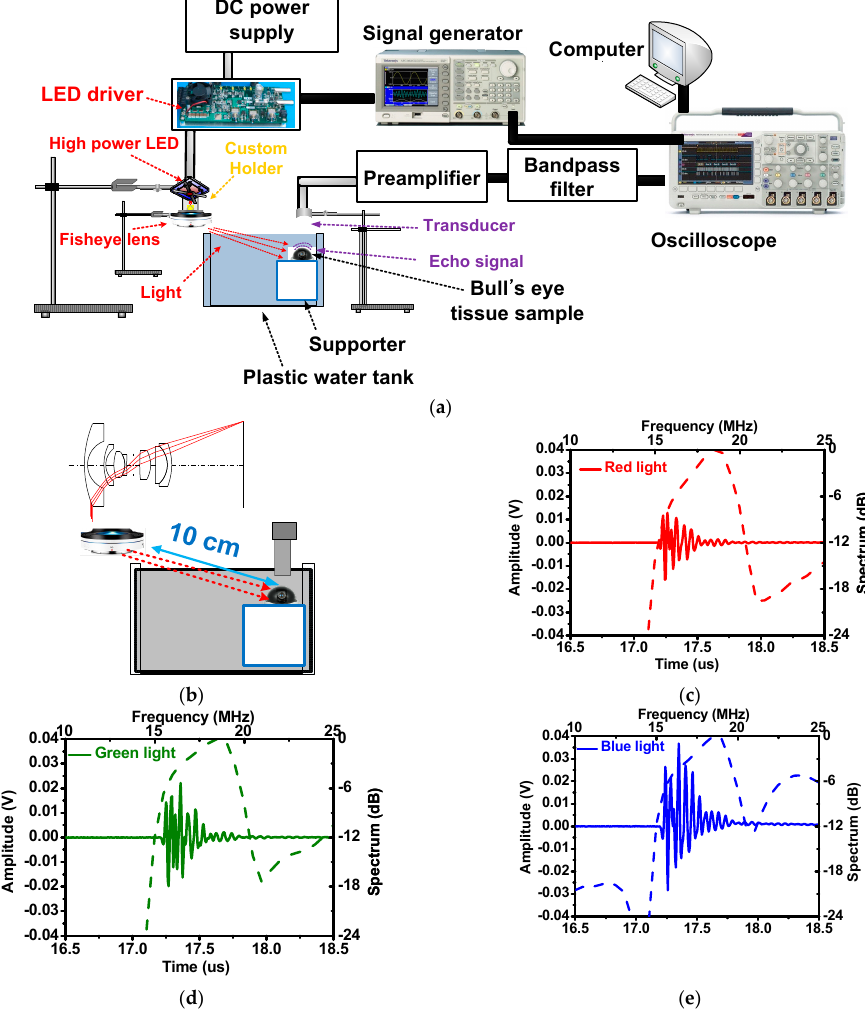
Figure 8. ( a ) Fisheye-lens-based PA system setup, ( b ) detailed setup of the LED and transducer, and the pulse-echo responses obtained using the ( c ) red, ( d ) green, and ( e ) blue LEDs.